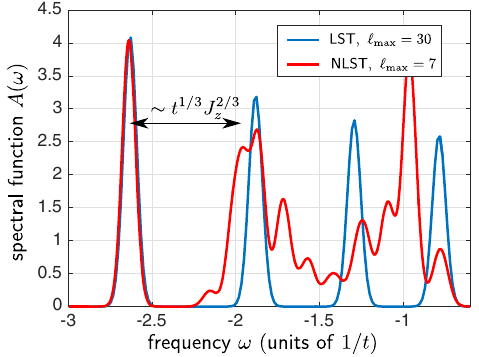
FIG. 22. The spectral function A ð ω Þ is calculated in the strong- coupling regime, here for J / t ¼ 0.2 and S ¼ 1 /2. We have z and energies E of all calculated the spectral weights Z n n eigenstates n and broadened them by hand for clearer presen- tation. LST predicts a series of approximately equally spaced peaks, which evolve into a broad continuum if string interactions are included in the NLST. The gap from the magnetic polaron peak at the lowest energy to the first excited states with appreciable spectral weight scales with the nontrivial power law t 1 /3 J 2 /3 characteristic of the string z